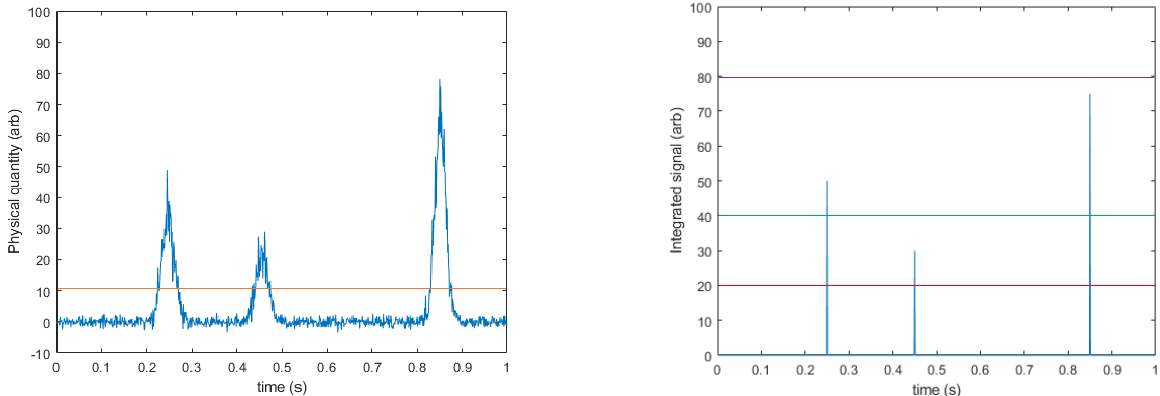
Figure 3. Basic principles behind PC approaches. (LEFT) Some physical feature of the system, such as the charge in a pixel, is shown varying continuously (blue line). Some level of noise is always present in these measurements; however, when a photon interacts with the detector material it causes a sharp and significant change in the measured quantity. A threshold is set (orange line) sufficiently above the noise floor such that any signal rises above this level indicate a photon interaction. A counter is then linked to this threshold and incremented whenever the threshold is crossed from below. The physical quantity then returns to baseline over some time, dt . (RIGHT) By using multiple threshold-counter pairs, the energy of each event can be broadly binned. In this example the counter associated with the lowest threshold (red line) would be incremented three times, the middle threshold counter (green line) incremented twice, and the highest-energy threshold counter (purple line) not incremented at all. The number of events between given thresholds is then determined by subtraction of adjacent counters. Adapted with permission from ref. [32]. Copyright 2021 The Institute of Cancer Research.